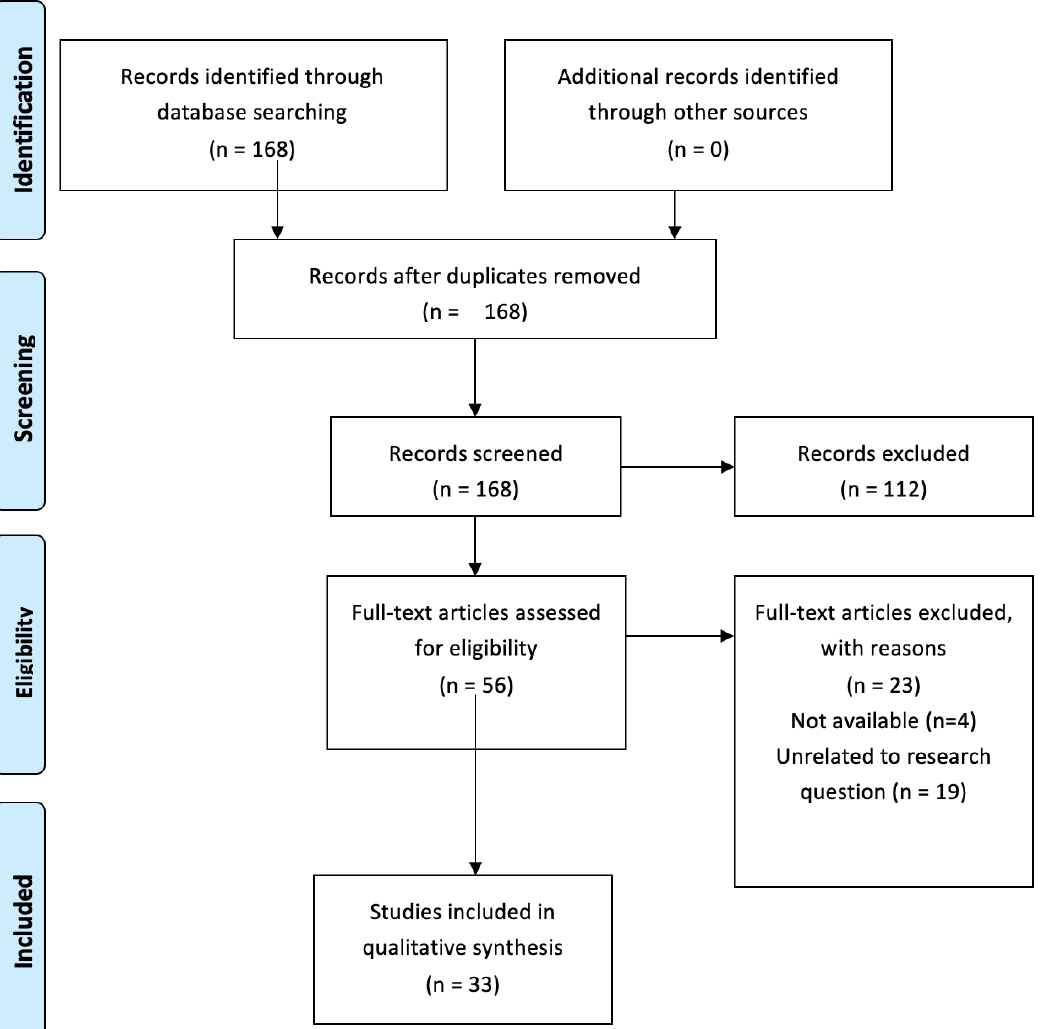
Figure A1. A systematic search was carried out through an online search in PubMed using the MeSH database. Additional relevant references from the obtained literature were reviewed. With exception of case reports, clinical trials and letters to the editor, we included all English-written studies based on original data for title and abstract screening, regardless of year of publication. As no articles directly assessed the topic of our review, our inclusion and exclusion criteria were dynamic, as new ideas emerged. A PRISMA flowchart was made including reasons for exclusion of the literature.